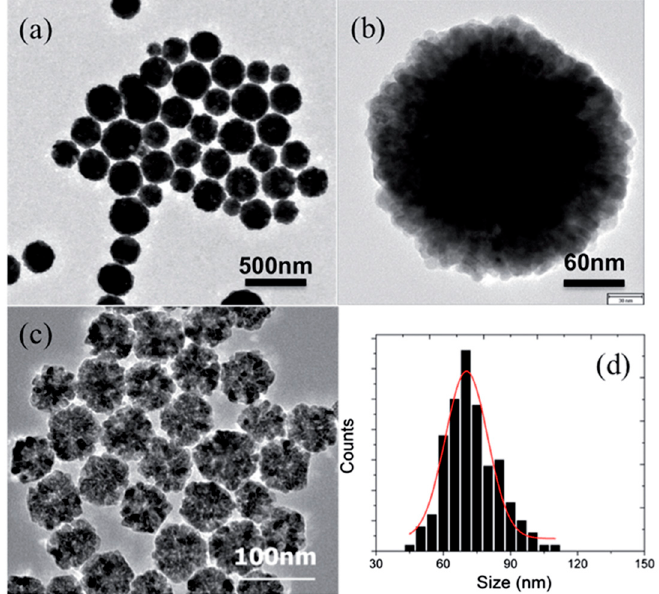
Figure 4. ( a , b ) TEM images of the CeO 2 nanospheres synthesised without the presence of Cu 2+ ; ( c ) TEM image of the Cu 0 . 10 Ce 0 . 90 O 2 nanospheres; ( d ) is the corresponding size distribution of the Cu 0 . 10 Ce 0 . 90 O 2 nanospheres [57]. Reproduced with permission from: Yang, F.; Wei, J.; Liu, W.; Guo, J.; Yang, Y. Copper doped ceria nanospheres: surface defects promoted catalytic activity and a versatile approach. J. Mater. Chem. A 2014 , 2 , 5662–5667—Published by The Royal Society of Chemistry.